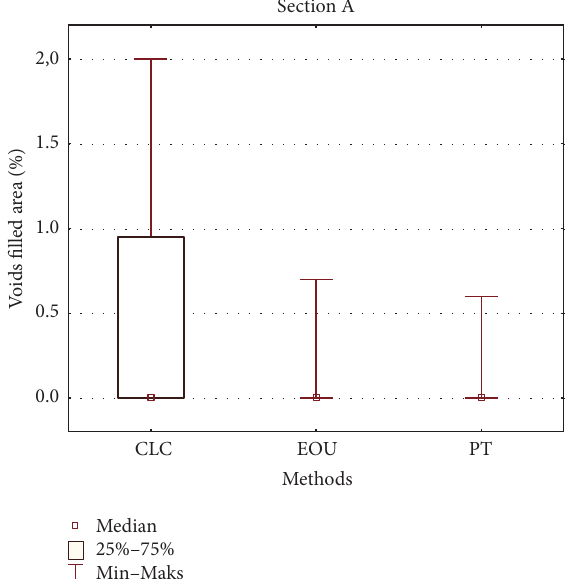
Figure 12: Box plots illustrating the median traces and minimal and maximal values of the voids in the filled area in each experimental group, section